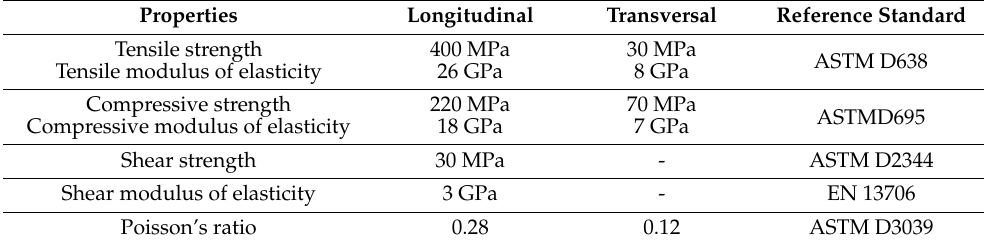
Table 3. Main mechanical properties of pultruded GFRP